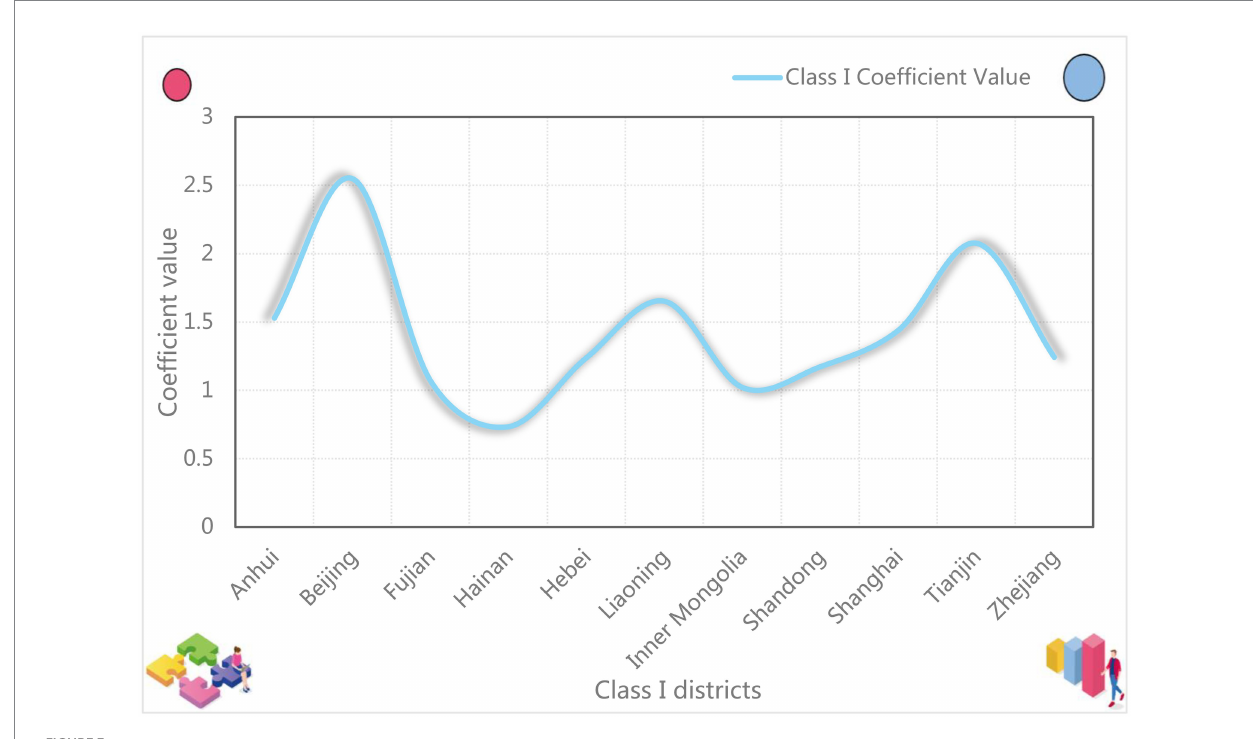
FIGURE 3 Comparison of coefficients in Class I districts.